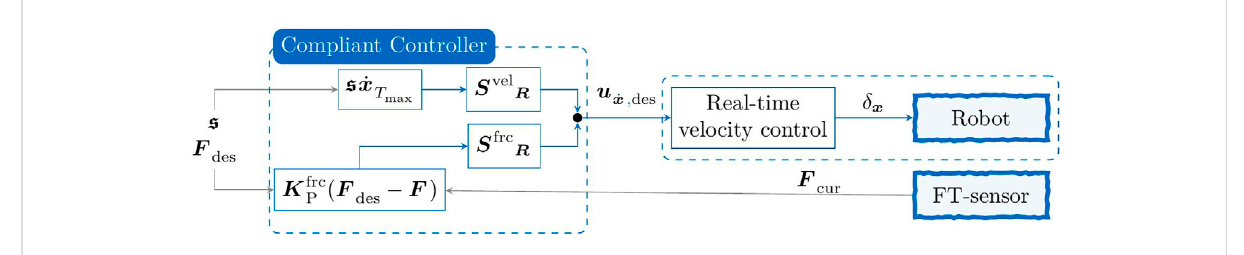
FIGURE 2 Schematic overview of a hybrid force – velocity controller (Craig and Raibert, 1979; Khatib and Burdick, 1986) using the Cartesian deviation control interface of an industrial COMAU robot. Here, the selection matrices S vel R and S frc R activate velocity — and force control modalities along selective axes using a scaled feed-forward velocity pro fi le s _ x T and a proportional force controller with the gain matrix K P , Cartesian FT readings F , max and the desired wrench F des . Eventually, the Cartesian velocity is emulated on the COMAU robot by using the Cartesian deviation command interface δ x